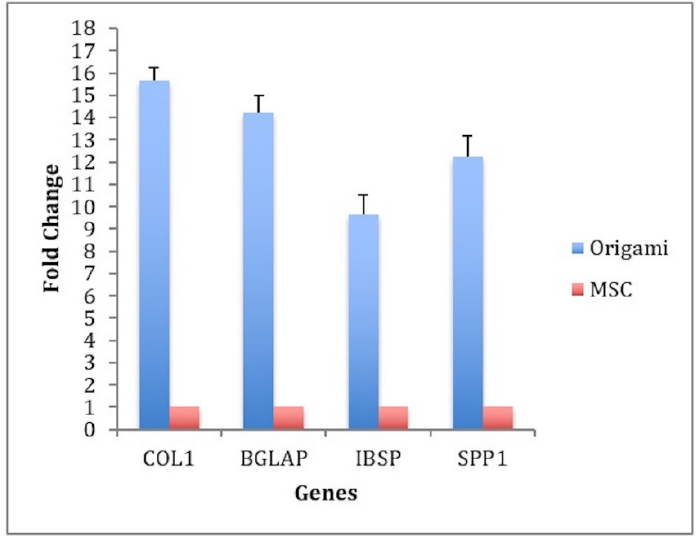
Figure 9. n-fold changes of bone-specific genes in the material and the control groups.